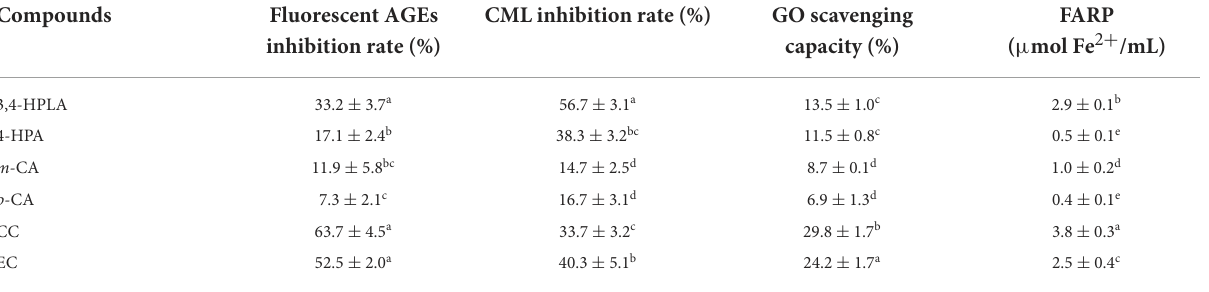
TABLE 3 Antiglycation, antioxidant, and α -dicarbonyl compound scavenging capacities of bioconversion products. Compounds Fluorescent AGEs inhibition rate